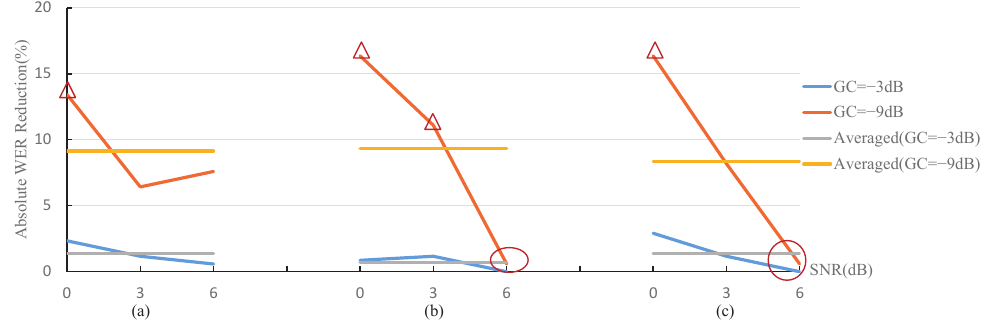
Figure 10. Absolute WER reduction under different noise and SNR conditions. ( a ) White noise. ( b ) Babble noise. ( c ) Factory1 noise.